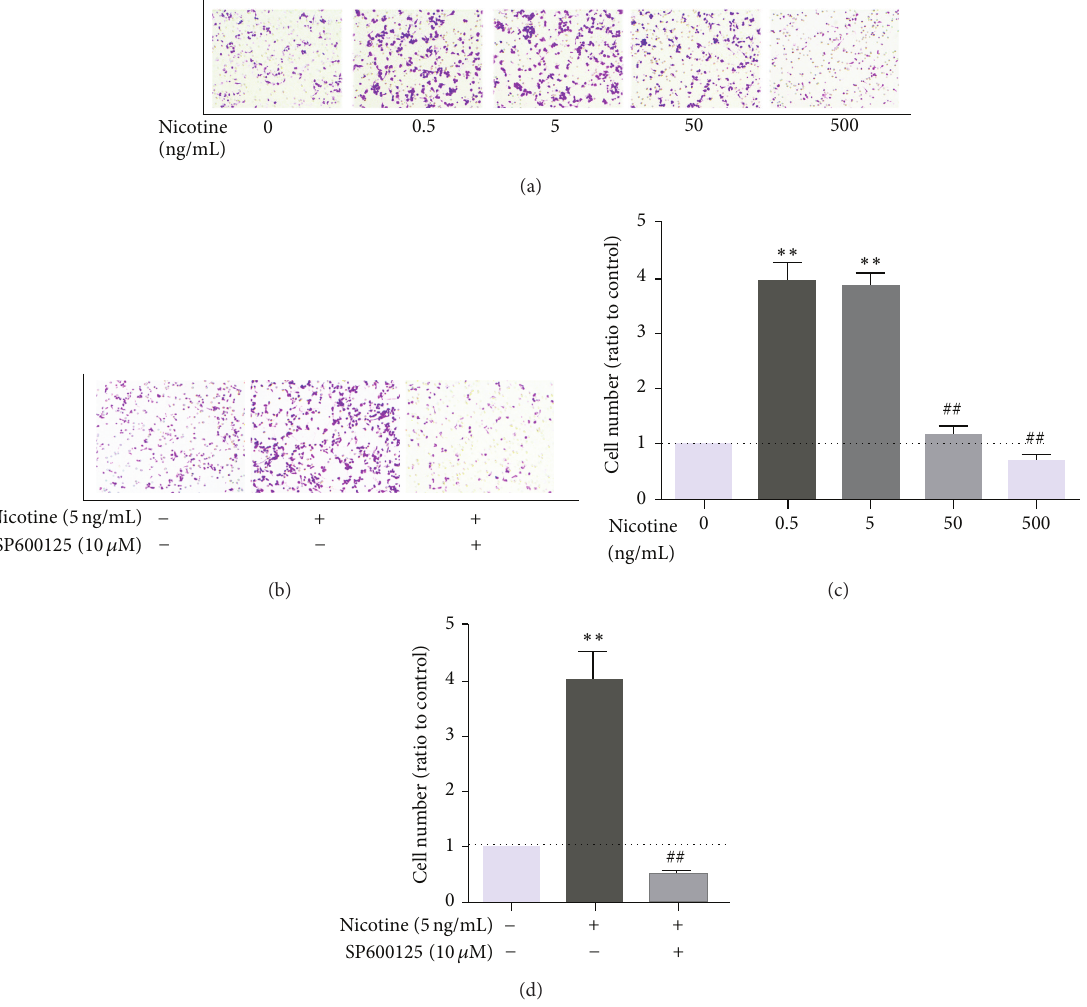
Figure 7: Transwell assay of macrophage migration. Representative pictures are shown. (a, b) Macrophages that had migrated to the lower chamber were counted after DAPI staining. (c, d) Bar graphs representing quantification of macrophage migration. Nicotine at 0.5 ng/mL or 5 ng/mL induced the strongest macrophage migration, while lower migration was observed following treatment at 50ng/mL and a significant inhibitory effect was noted at a 500-ng/mL concentration. SP600125 inhibited the migration of macrophages. ∗ 𝑃 < 0.05 and ∗∗ 𝑃 < 0.01 versus control; # 𝑃 < 0.05 and ## 𝑃 < 0.01 versus the group treated with 5ng/mL